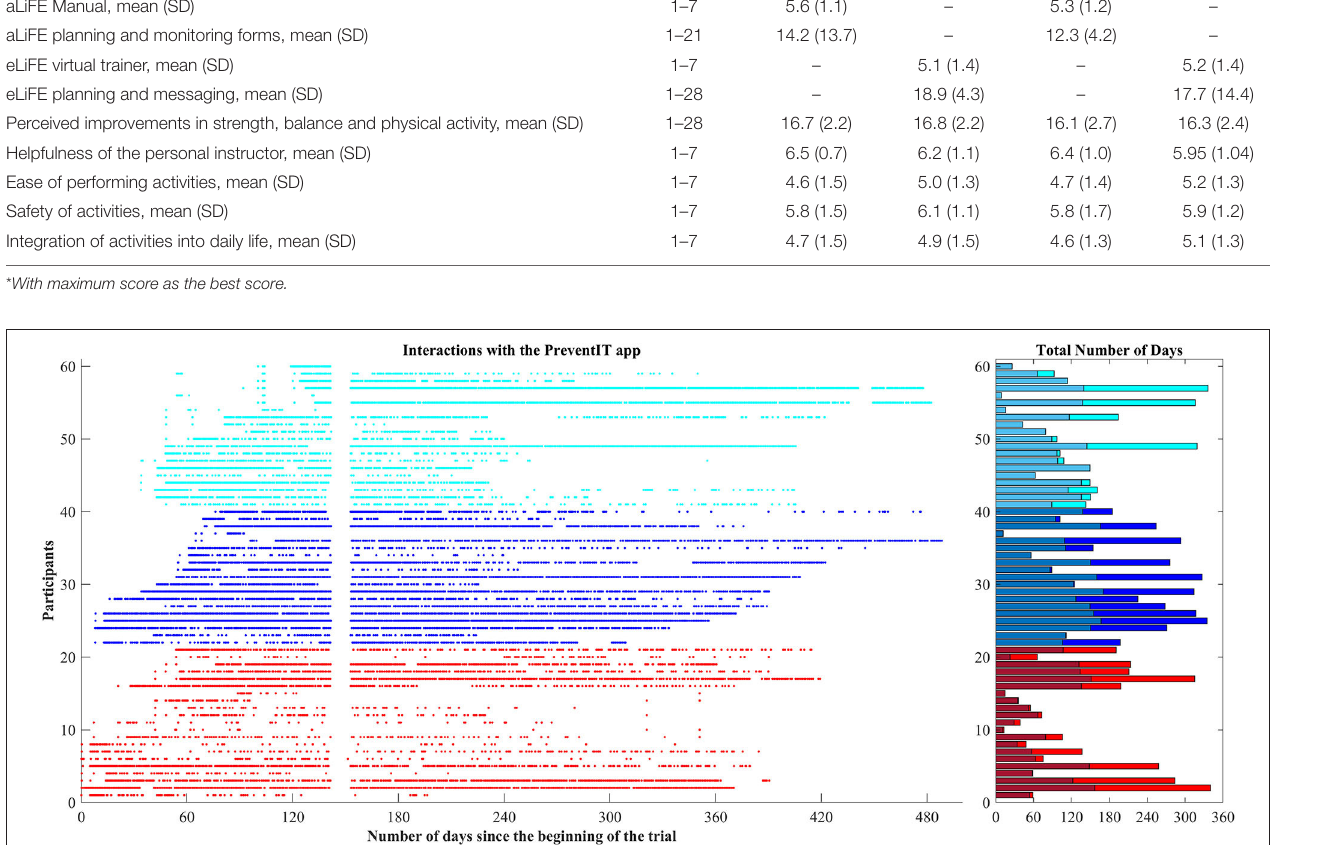
FIGURE 2 | eLiFE participants’ interactions with the